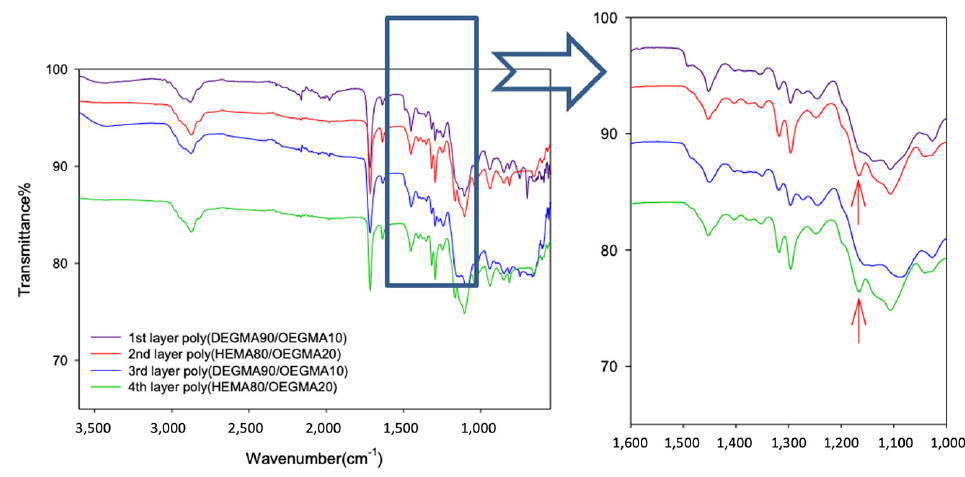
Figure 3. FT-IR spectra of MLTRPBs on titanium implants. Red arrows indicate OH bending vibration. The static water contact angles of poly (DEGMA 90 -co-OEGMA 10 ) and poly (HEMA 20 - co-OEGMA 80 ) were measured at 43.2 ± 1.5 ◦ and 76.1 ± 2.4 ◦ , respectively. As expected, the poly (HEMA 20 -co-OEGMA 80 ) layer containing hydrophilic HEMA had greater wettability than the poly (DEGMA 90 -co-OEGMA 10 ).